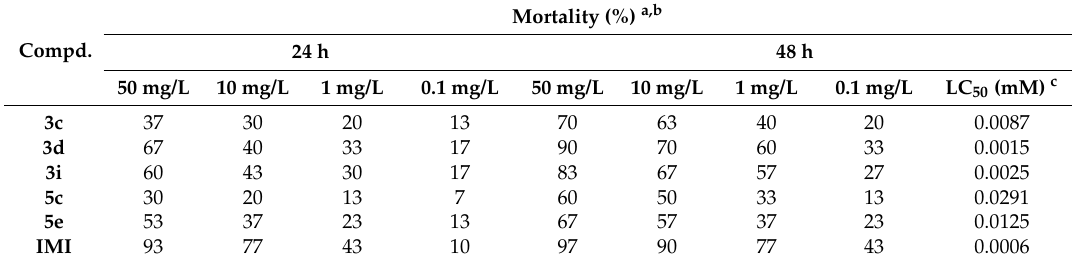
Table 3. Insecticidal activities of compounds 3c , 3d , 3i , 5c , 5e and imidacloprid (IMI) against B. brassicae .